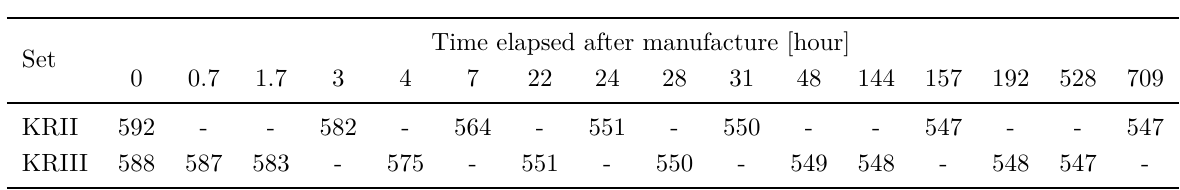
Table 2. Time course of the test bodies average weight [g].